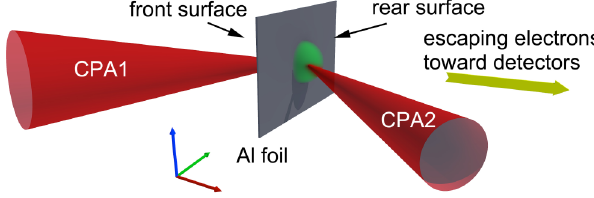
FIG. 1. Schematic of the experimental setup. Two laser pulses (CPA1 and CPA2) are focused on the Al target (thickness: 11 μ m).